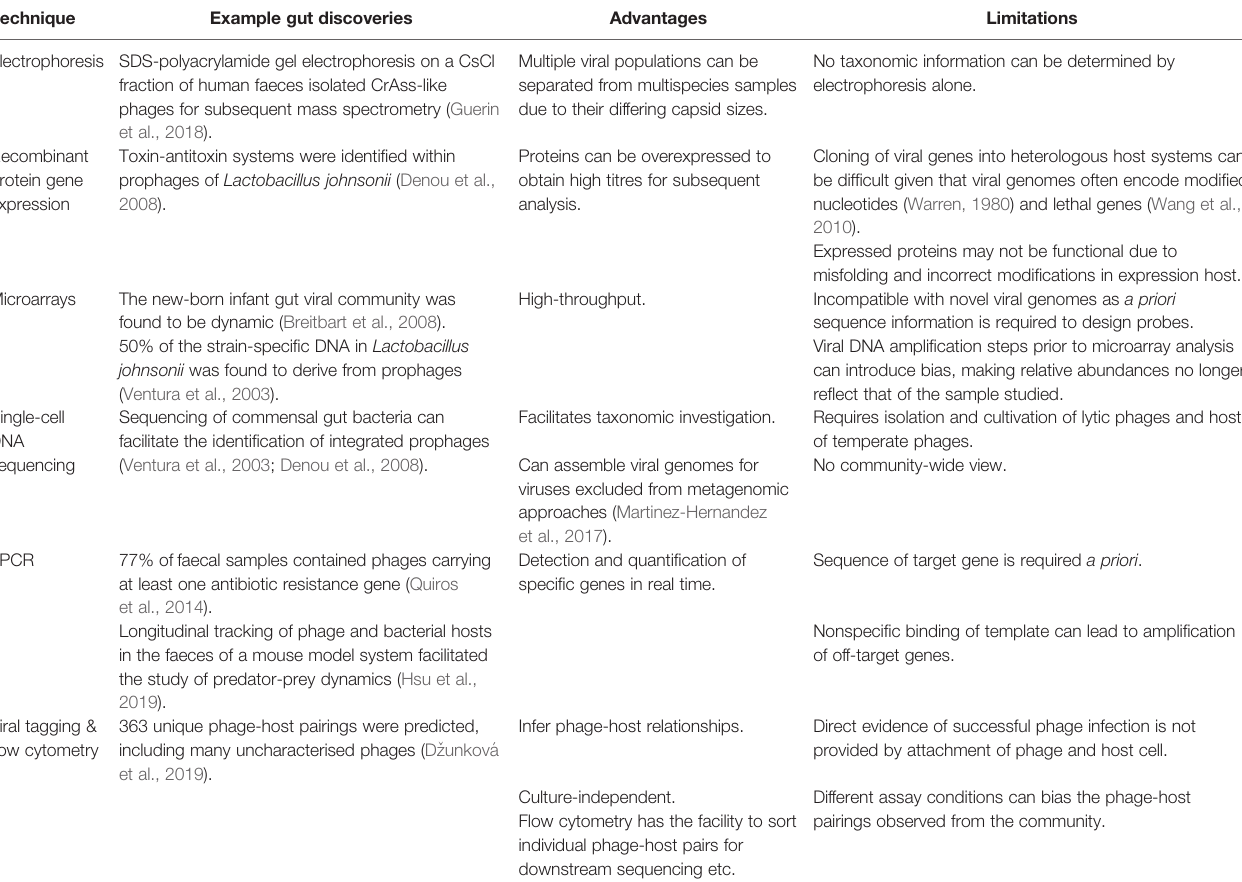
TABLE 2 | Summary of molecular biology techniques used to study the gut phageome, including the major advantages and limitations of each technique. Technique Example gut discoveries Advantages